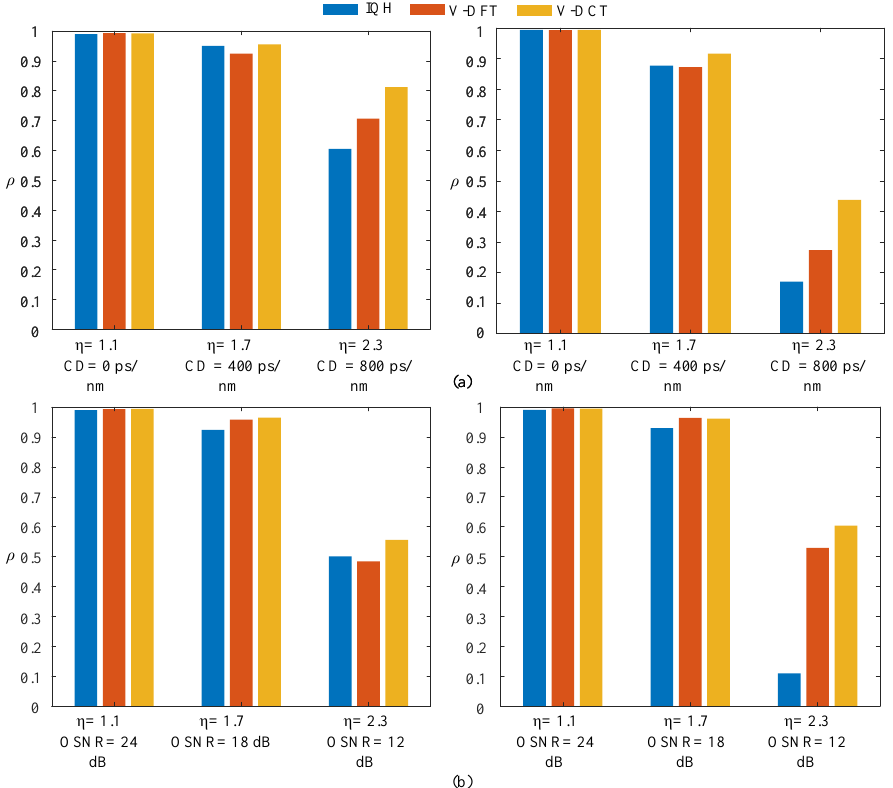
Figure 12. Comparisons between monitoring results using different feature types of both side (left) and middle (right) sub-carriers: ( a ) OSNR monitoring and ( b ) CD